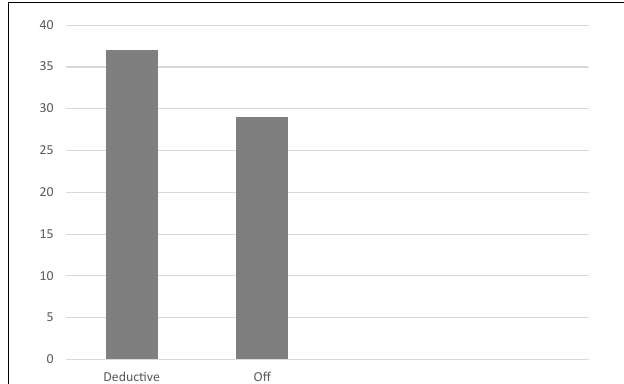
FIGURE 3 | Rhetorical organization types in students’ argumentative essays in this study.